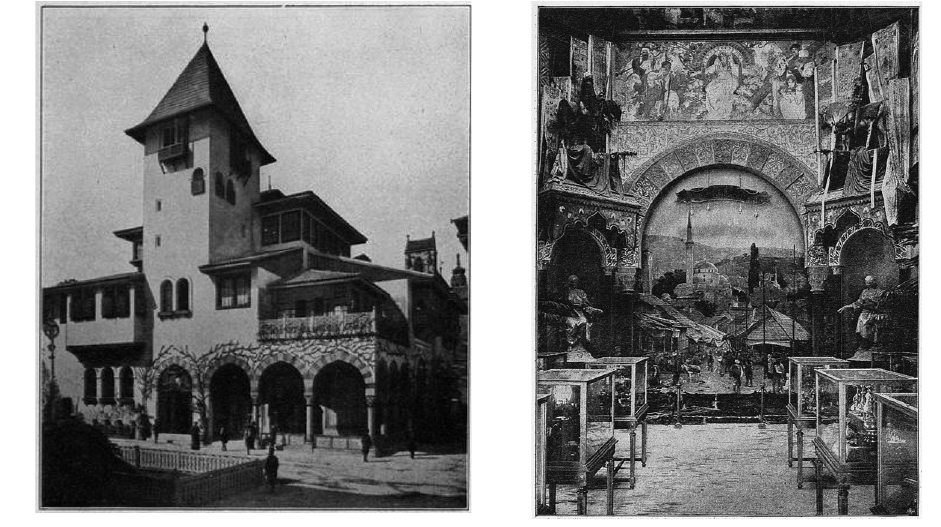
FIGURE 3 (left) Bosnian-Herzegovinian pavilion, World’s Fair in Paris, 1900, exterior, from: Die Weltausstellung in Paris , edited by A. J. Meier- Graefe. Paris: F. Krüger 1900, 30. FIGURE 4 (right) Bosnian-Herzegovinian pavilion, World’s Fair in Paris, 1900, interior, from: Fromm, Carl Jos. 1900. “Bosnien und die Hercegowina auf der Pariser Weltausstellung.” In Die Pariser Weltausstellung in Wort und Bild , edited by Georg Malkowsky, Berlin: Verlag Kirhhoff & Co. 1900,